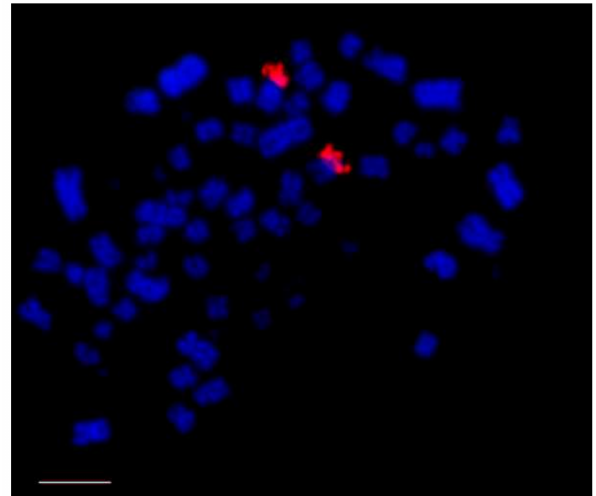
Figure 2. Distribution of 18/28S rDNA (red signals, CY3) in Buteogallus meridionallis (Accipitriformes), in the short arm of a medium pair of macrochromosomes. Chromosomes counterstained with DAPI (blue). rDNA: ribosomic DNA. Scale bar: 5 µ